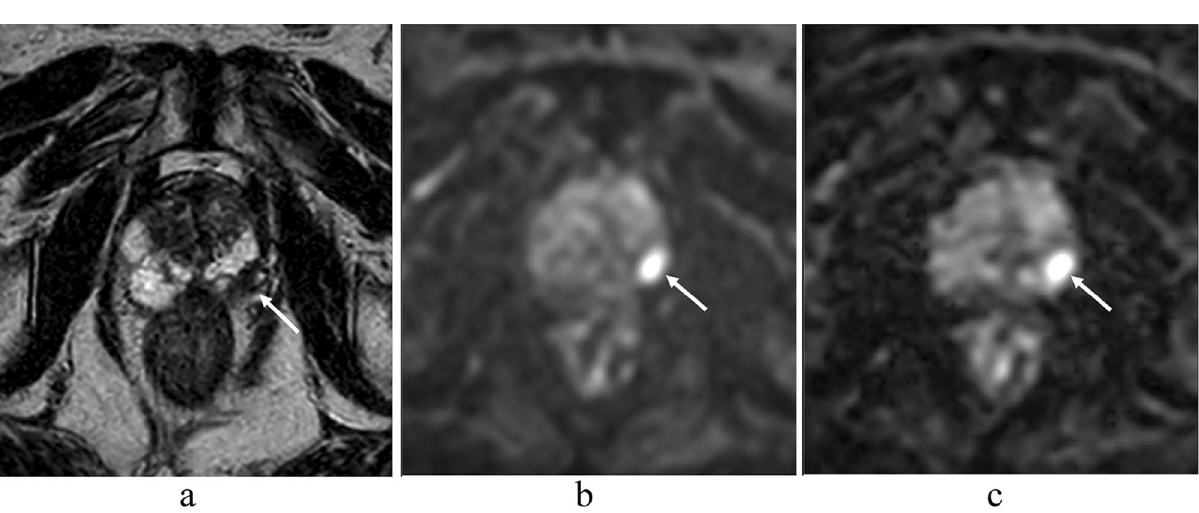
Figure 2. An 83-year-old man with prostate cancer (PSA level, 6.60 ng/mL; Gleason score, 3 + 4) in the left peripheral zone. A homogeneous hypointense lesion is seen on T2-weighted imaging ( a ) (arrow). A focal hyperintensity is depicted clearly on ssEPI DWI ( b ) and msEPI DWI ( c ) (arrow). The clarity of the prostate edge is better in msEPI DWI ( c ) compared with ssEPI DWI ( b ). PSA prostate-specific antigen, ssEPI single-shot echo- planar imaging, DWI diffusion-weighted imaging, msEPI multi-shot echo-planar